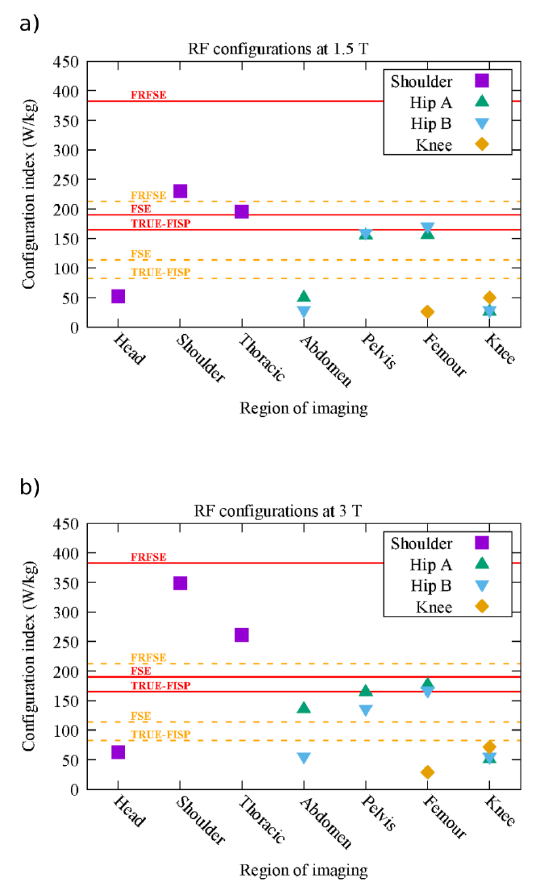
Figure 4. Configuration index ξ 10 g , C for the most stressed situations at 1.5 T ( a ) and 3 T ( b ). The maximum values of this index ( ξ 10 g , Max ) admissible for condition (1) and (2) associated with the TrueFISP, T1 FSE, and T2 FRFSE sequences are reported as solid lines (condition 1) and dotted lines (condition 2). For compatibility reasons, the values of 10𝑔,𝐶 for knee are fictitiously halved.